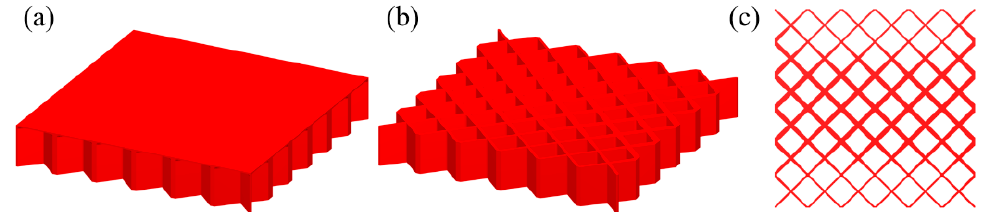
Table 1. Design and FEA parameters of the geometry. Figure 10. Optimized TWSS using the HLSM. ( a ) Optimized TWSS. ( b ) Optimized layout of stiffening ribs. ( c ) Top view of stiffening ribs. Model Size Material Properties